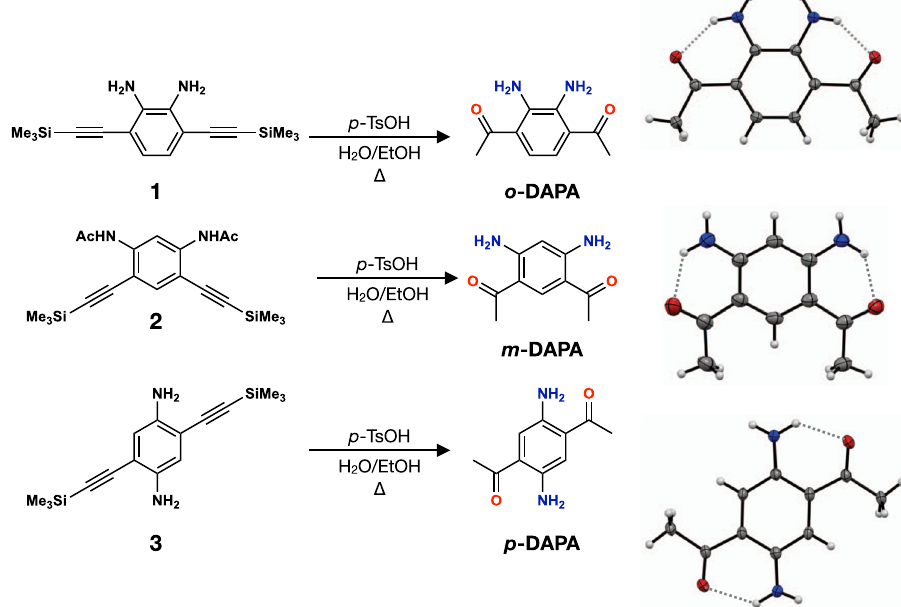
Fig. 2 Construction of isomeric single benzene fl uorophores. Synthetic routes for o -, m -, and p -DAPA. p -TsOH para -toluenesulfonic acid, EtOH ethanol.